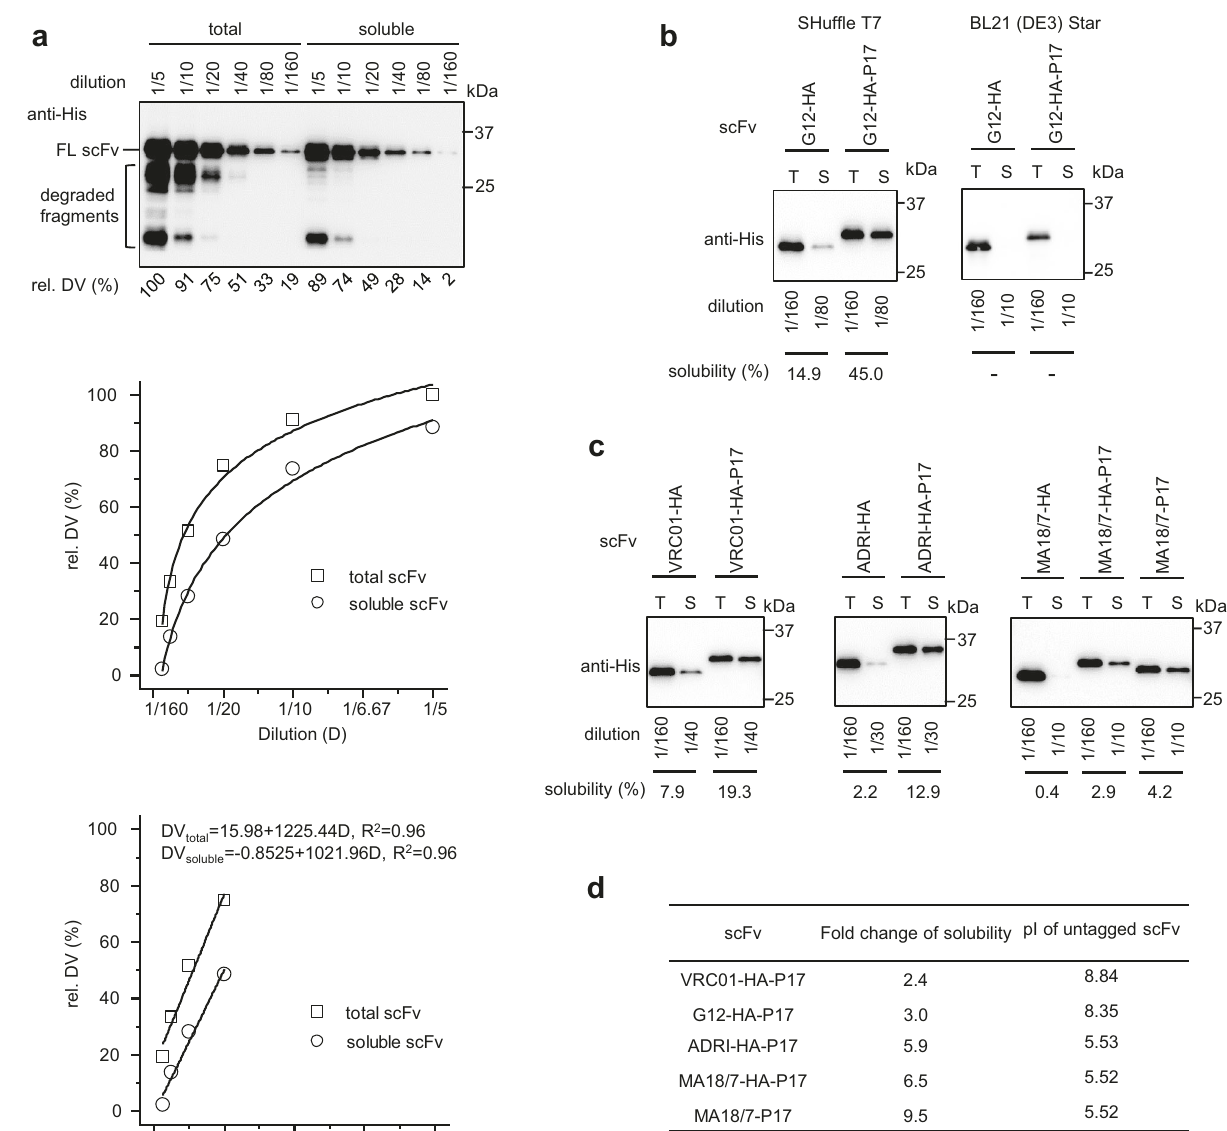
Fig. 1 | P17 tag enhanced solubility of four scFvs in E. coli SHuf fl e T7 cells. a Determination of dilution ranges of total and soluble fractions of G12-scFv-HA proteinforlinearcorrelationwithwesternblottingsignals.Upperpanel:ScFvsfrom 5 μ l total and soluble bacterial protein samples serially diluted with 2× SDS-PAGE loadingbufferweredetectedbywesternblottingusingananti-His-tag.Therelative density value (rel. DV) of each full-length (FL) scFv was obtained by setting the density of total scFv diluted by 1/5 at 100%. Middle panel: Over the entire dilution range rel. DV of both total and soluble scFvs correlated with dilutions logarith- mically as calculated by the non-linear fi tting program of Origin 8.0 software. Bottom panel: In the dilution range from 1/20 to 1/160, rel. DV of both total and solublescFvscorrelatedlinearlywithdilutionsasful fi lledbyalinear fi ttingprogram